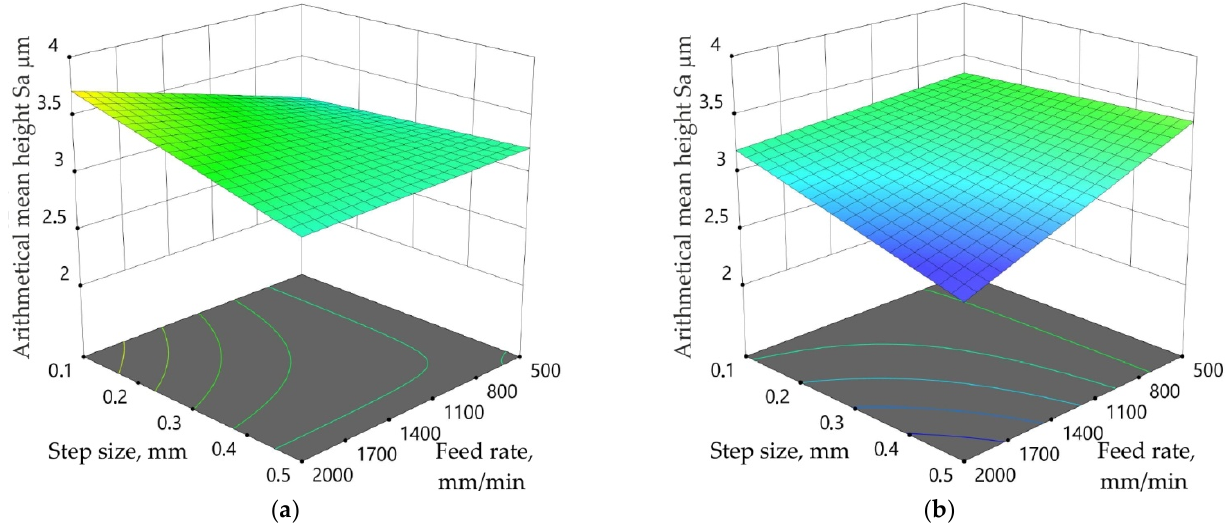
Figure 15. Response surface plots presenting the interaction between step size and feed rate af- fecting the arithmetical mean height Sa measured on outer surface of the drawpiece for n = 495 rpm and toolpath ( a ) conventional and ( b ) climb strategies. toolpath ( a ) conventional and ( b ) climb